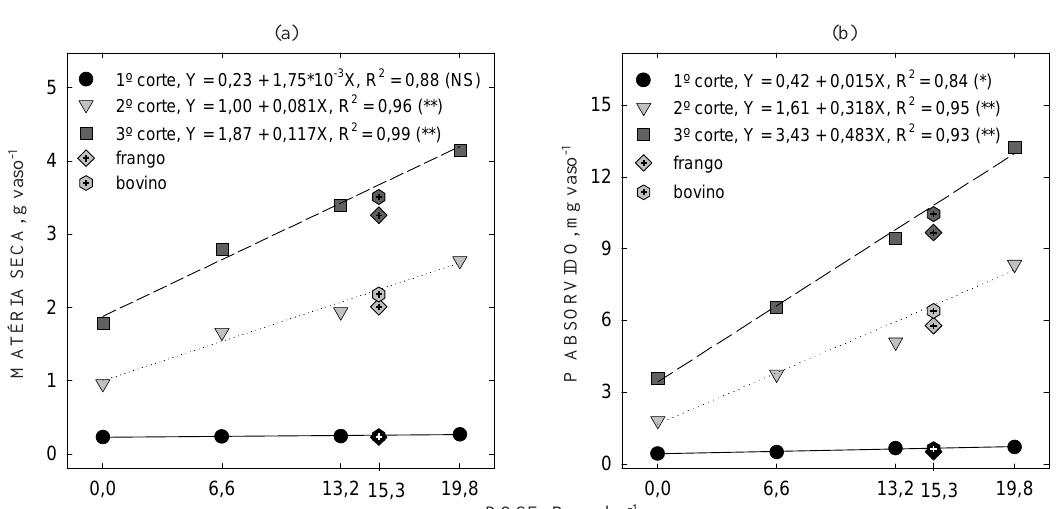
Figura 1. Rendimentos de matéria seca (a) e fósforo absorvido (b) acumulados em três cortes de milheto, considerando quatro doses de superfosfato triplo e a dose 15,3 mg kg -1 de P de onze amostras de estrumes de frango e de bovino de leite, aplicadas num Podzólico Vermelho-Escuro. * significativo a 5%. ** significativo a